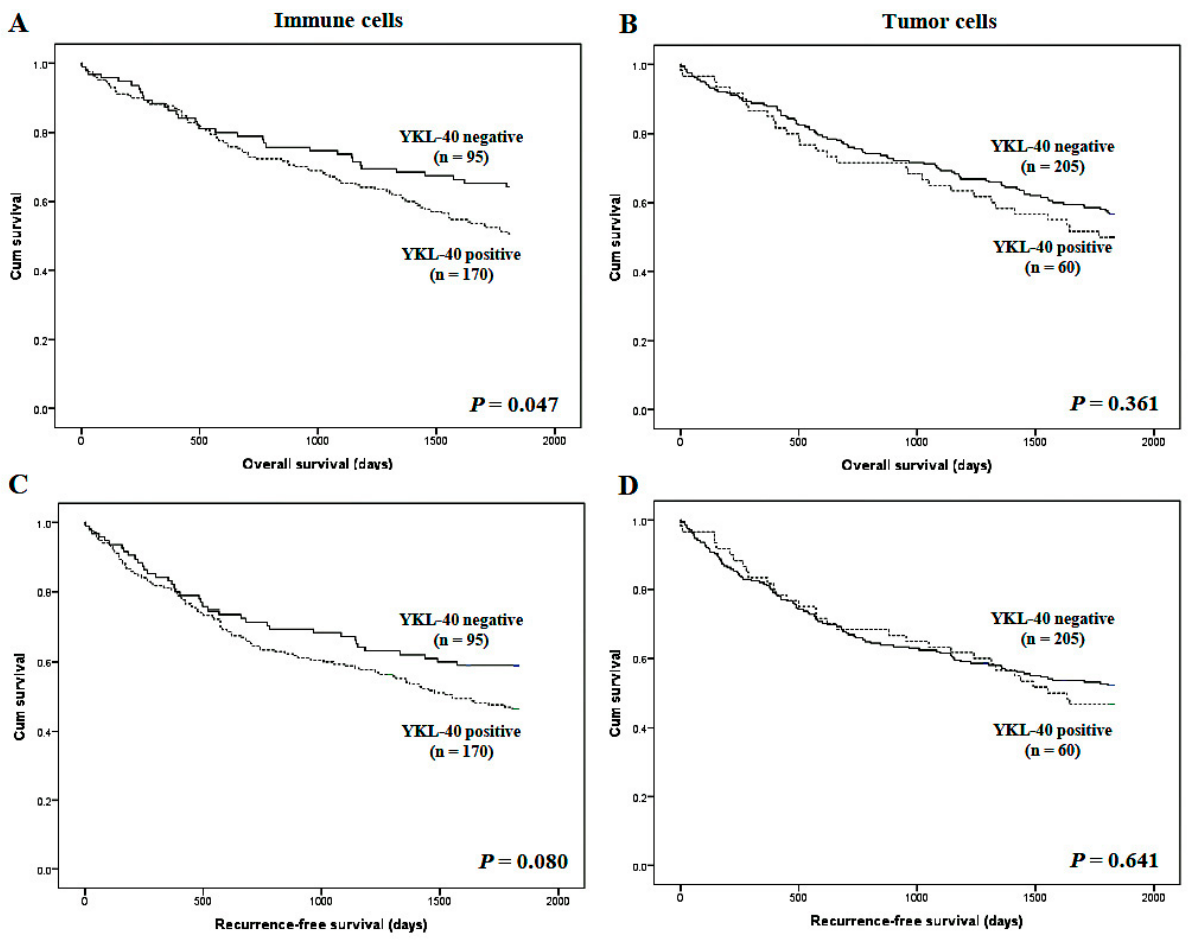
Figure 2. Kaplan–Meier analysis of patient survival according to YKL-40 expression in overall cases. ( A ) Overall survival according to YKL-40 expression in immune cells. ( B ) Overall survival according to YKL-40 expression in tumor cells. ( C ) Recurrence-free survival according to YKL-40 expression in immune cells. ( D ) Recurrence-free survival according to YKL-40 expression in tumor cells.